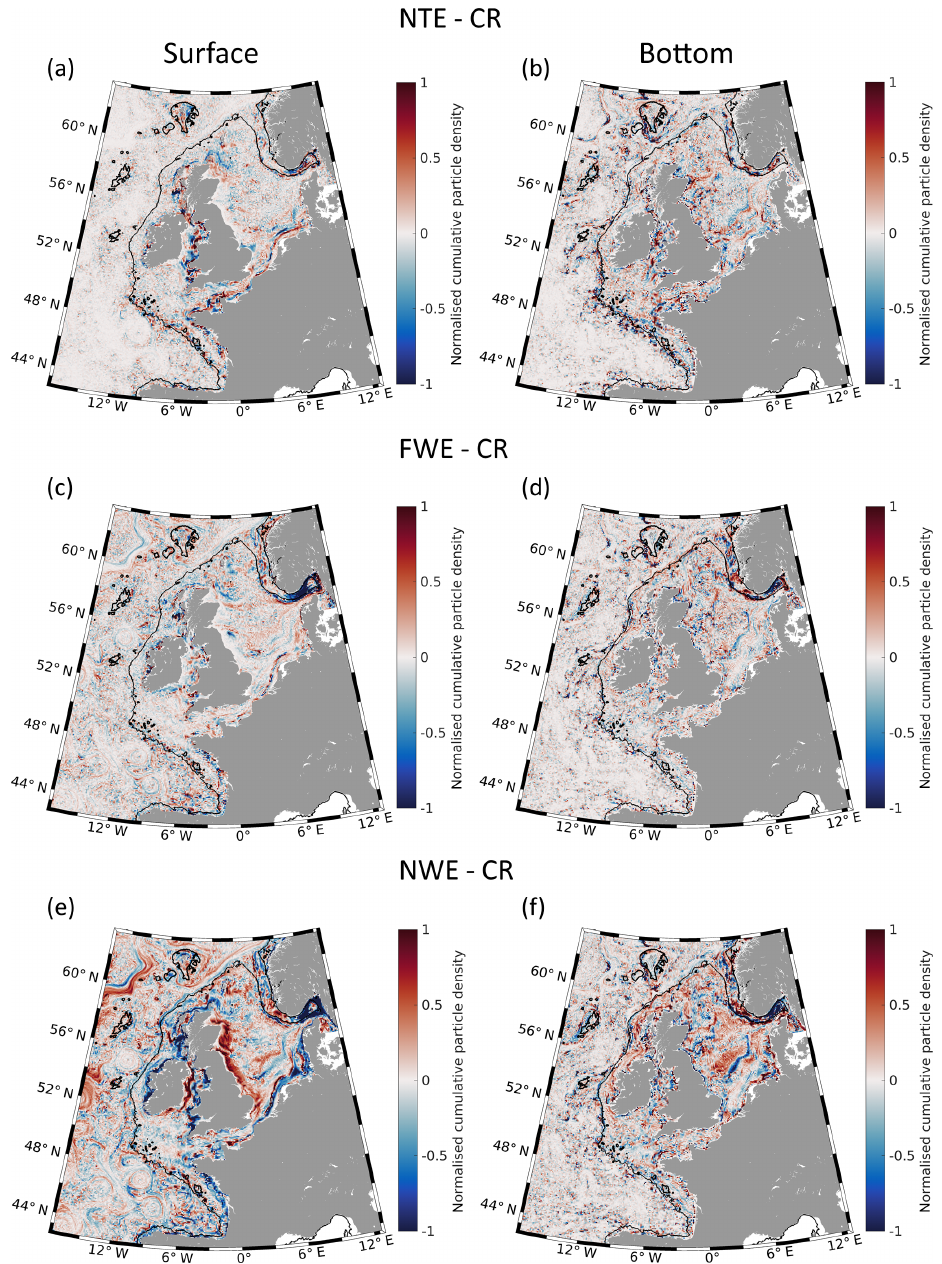
Figure 6. Analysis of the sensitivity experiments with respect to tides and wind. Panels (a) and (b) are the differences of normalised cumulative particle density (NCPD) in the non-tidal experiment (NTE, no. 2; see Table 1) minus the control run (CR, no. 1) in January 2015 at (a) the surface and (b) bottom. Panels (c) and (d) are the corresponding differences between the filtered wind experiment (FWE, no. 3) and the CR; panels (e) and (f) are the differences between the non-wind experiment (NWE, no. 4) and the CR.